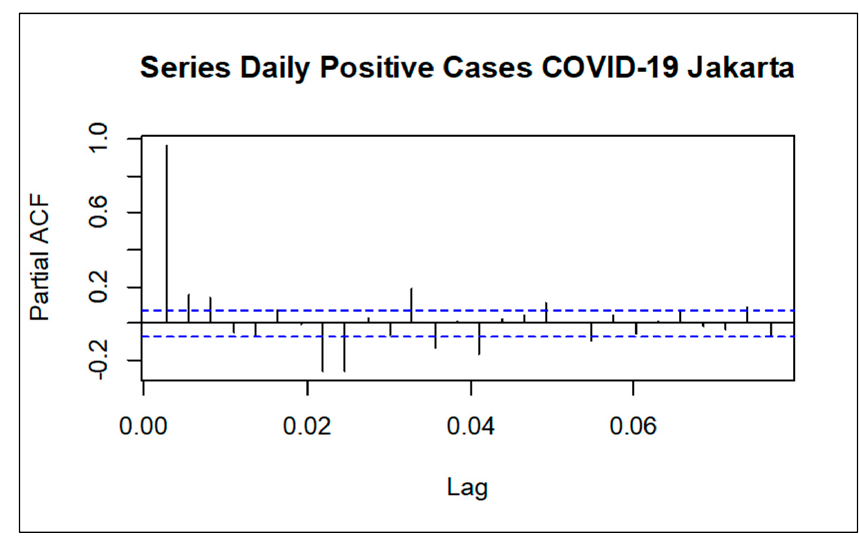
Figure 3. PACF Plot for Daily Confirmed Positive Cases of COVID-19 Data in Jakarta.